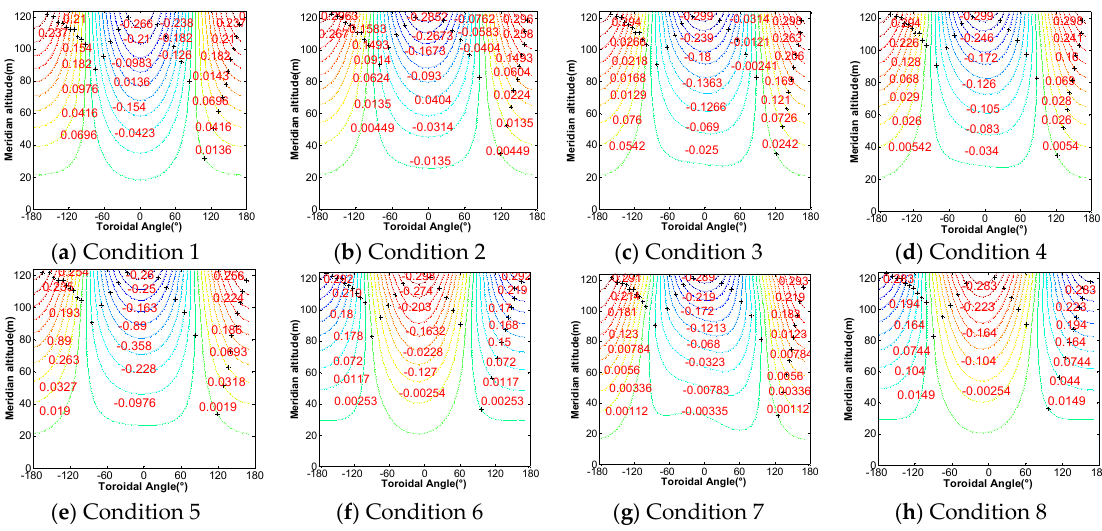
Figure 22 . Distributions of mean radial displacement of the tower body under different conditions. Figure 22. Distributions of mean radial displacement of the tower body under di ff erent conditions. Distributions of RMS of radial displacement under di ff erent conditions are shown in Figure 23. The RMS on windward and leeward of the tower are large. RMS of radial displacement on leeside of the tower body was high when the inflow split and fell at blades. Besides, the relative position between blade root and tower body would influence RMS of leeside significantly. With the